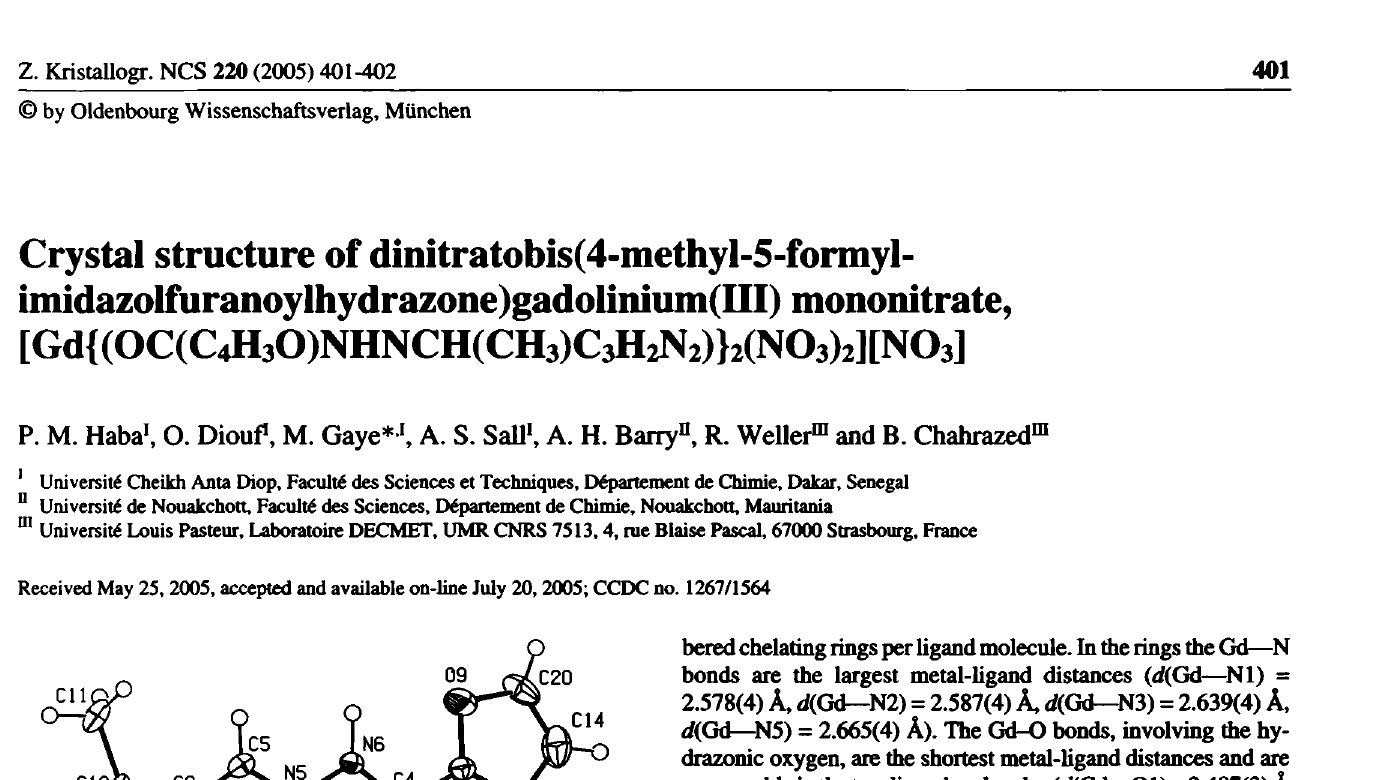
Table 1. Data collection and handling.